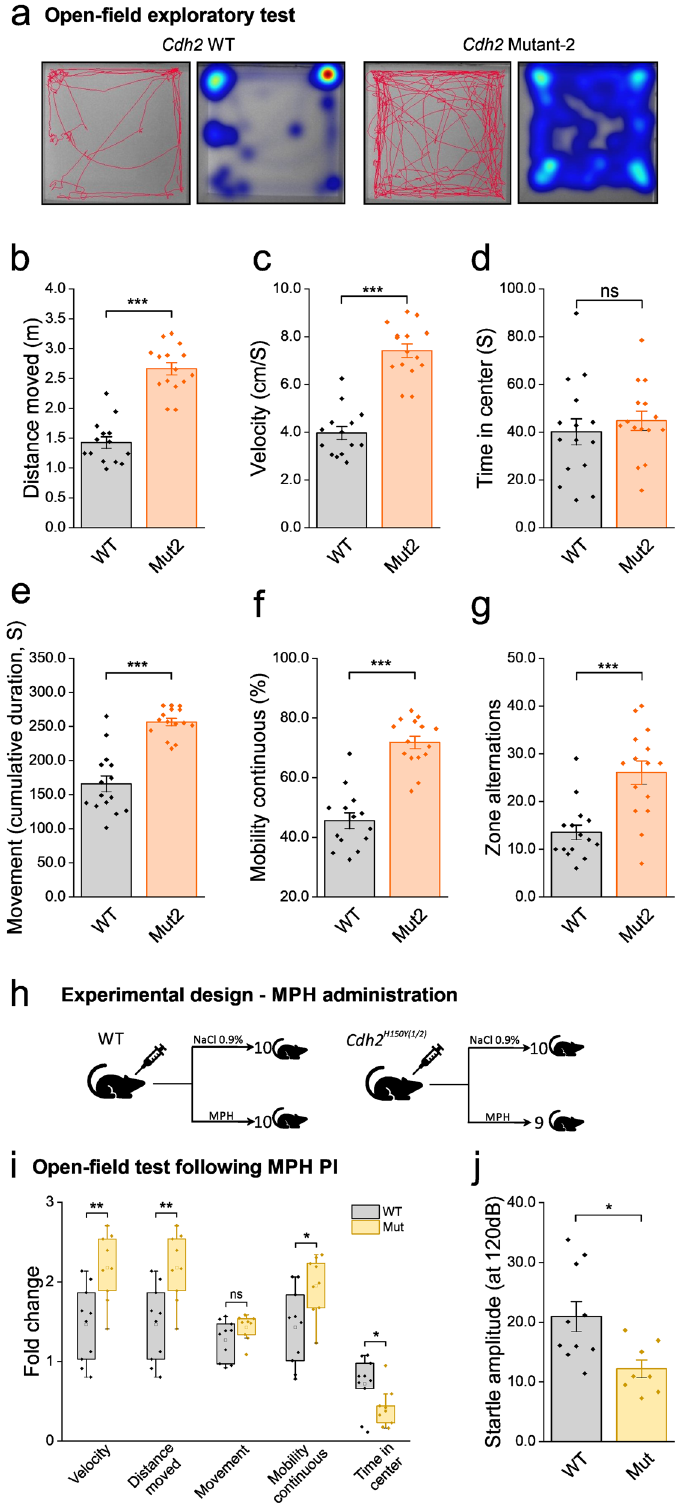
endocytosis takes place (Fig. 6a, upper inset). No difference was observed between the two genotypes, further demonstrating that the mutation had no impact on the kinetics of SV recycling. The frequency of spontaneous synaptic release is lower in Cdh2 slices . A reduction in total vesicle population or SV clusters in presynaptic terminals and a decrease in the RRP could lead to a